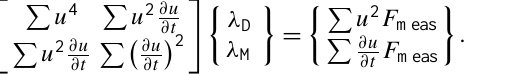
The drag coefficient ranges between C D = 0.8 and C D = 1.9, and tends to remain constant over the entire in- vestigated range of the Reynolds number obtained for soli- tary waves ( Re = 1.24 × 10 5 − 1.2 × 10 6 ). Such a